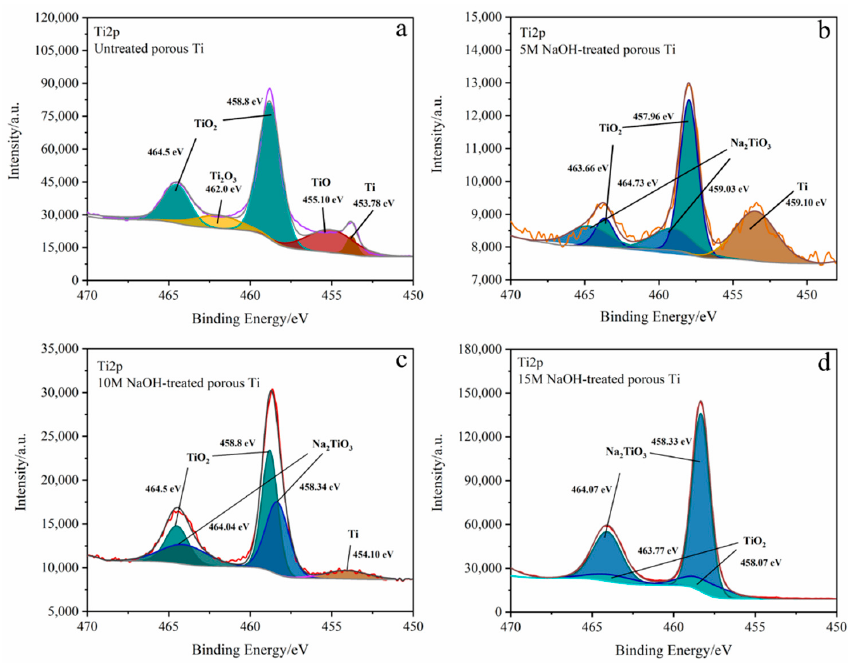
Figure 7. The high-resolution fine-peak fitting of Ti2p after alkaline treatment with different concentrations of NaOH, ( a ) Ti2p peak fitting diagram of untreated porous Ti. ( b ) Ti2p peak fitting diagram of 5 M NaOH-treated porous Ti. ( c ) Ti2p peak fitting diagram of 10 M NaOH-treated porous Ti. ( d ) Ti2p peak fitting diagram of 15 M NaOH-treated porous Ti.